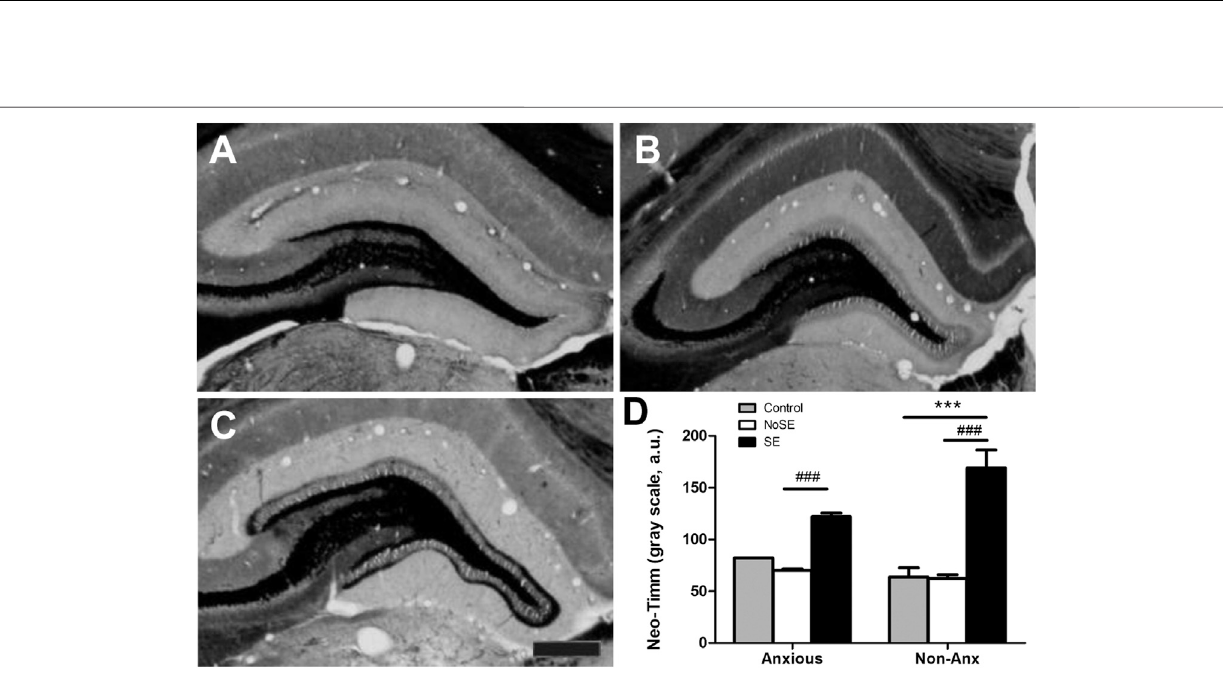
Frontiers in Pharmacology |